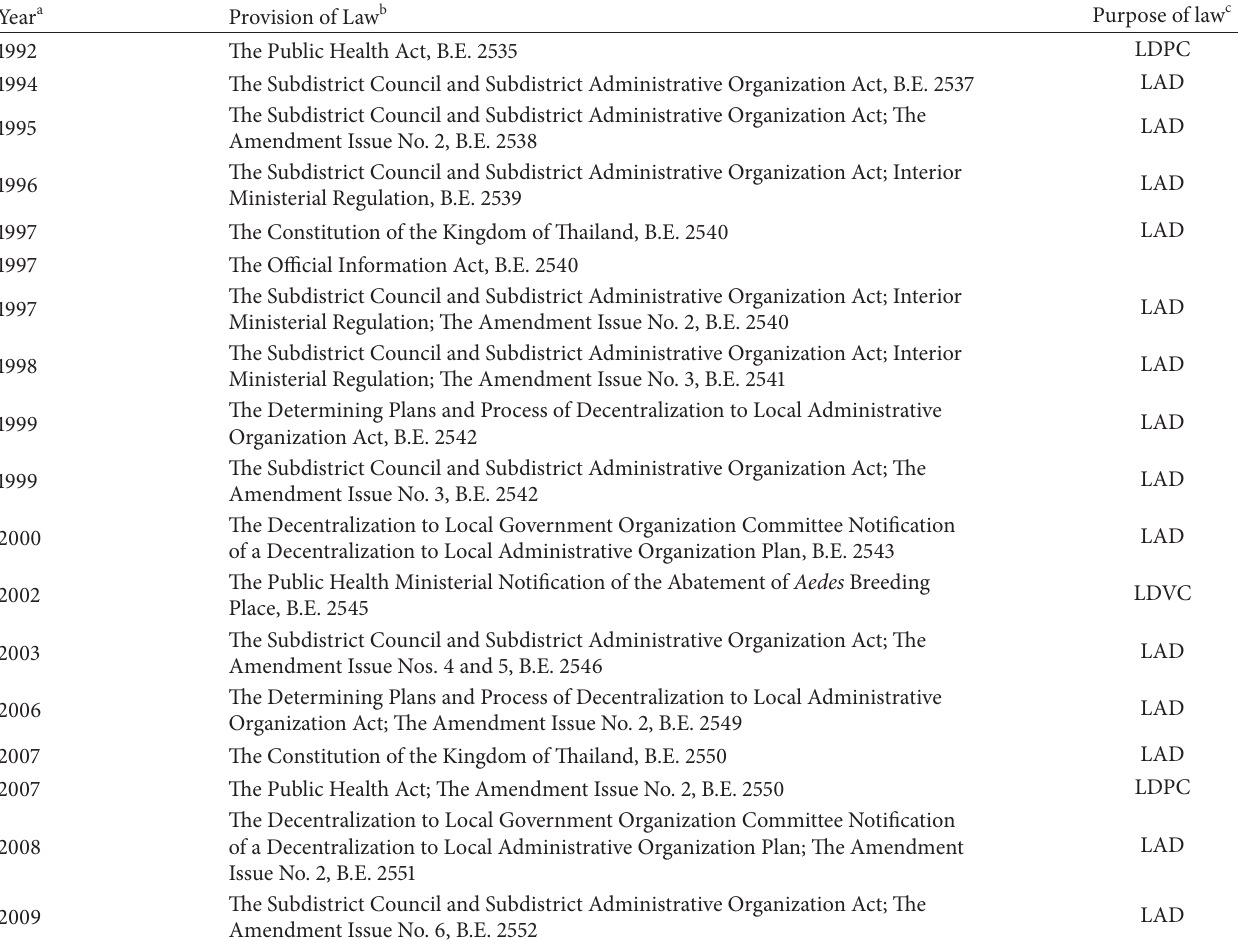
Table 2: Milestone of provisions of the laws regarding local administration development and disease prevention and control by the SAO,